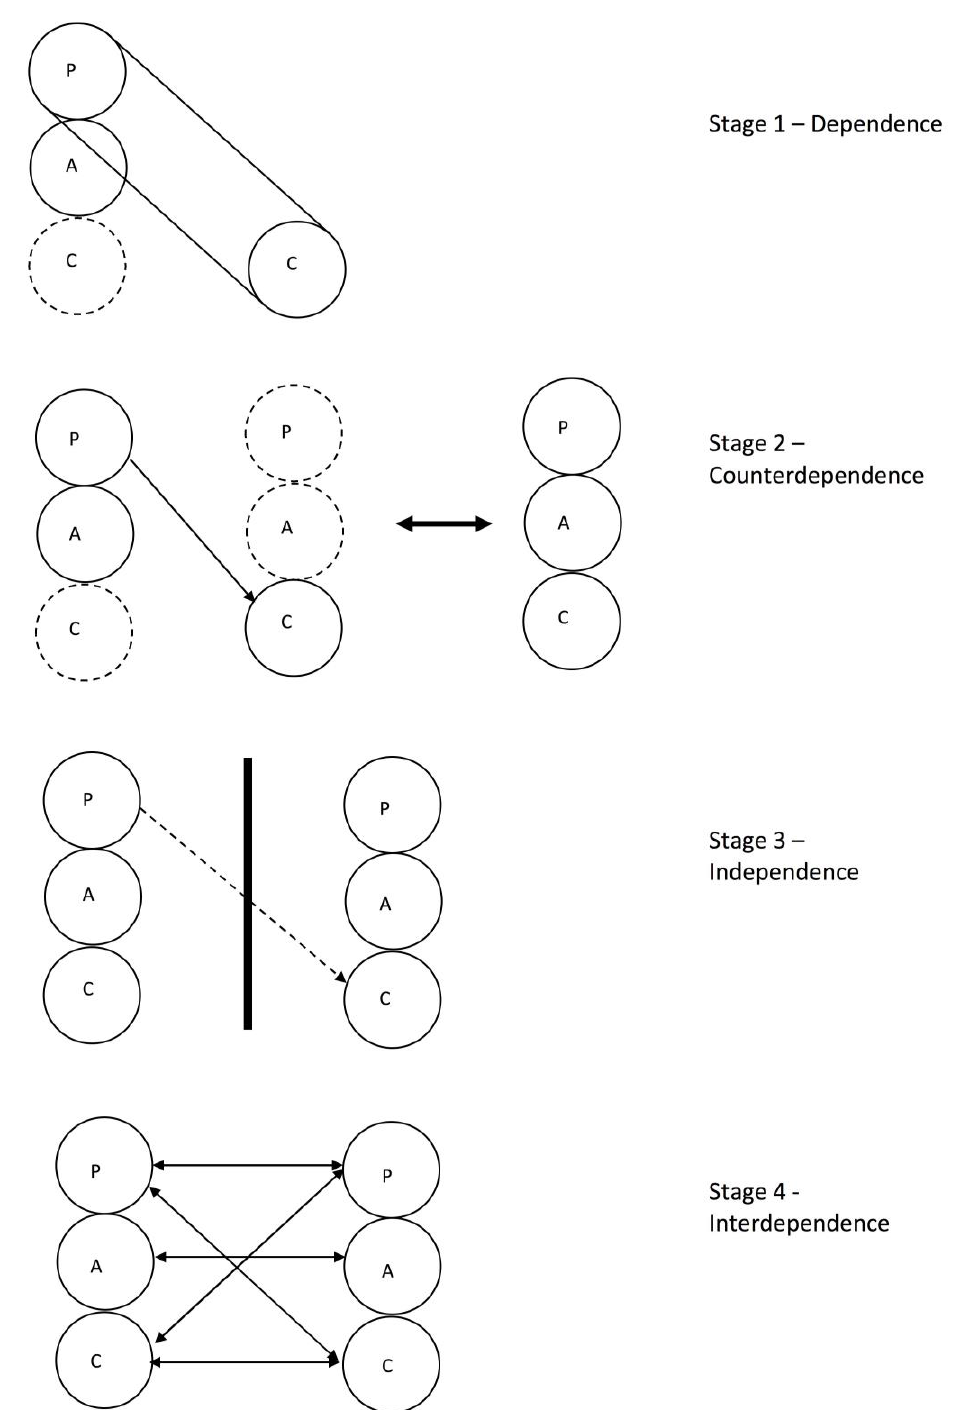
Figure 10: Hay’s 1991 Adaptation of Lenhardt’s diagram of stages (This diagram amended 1 July 2018 after first